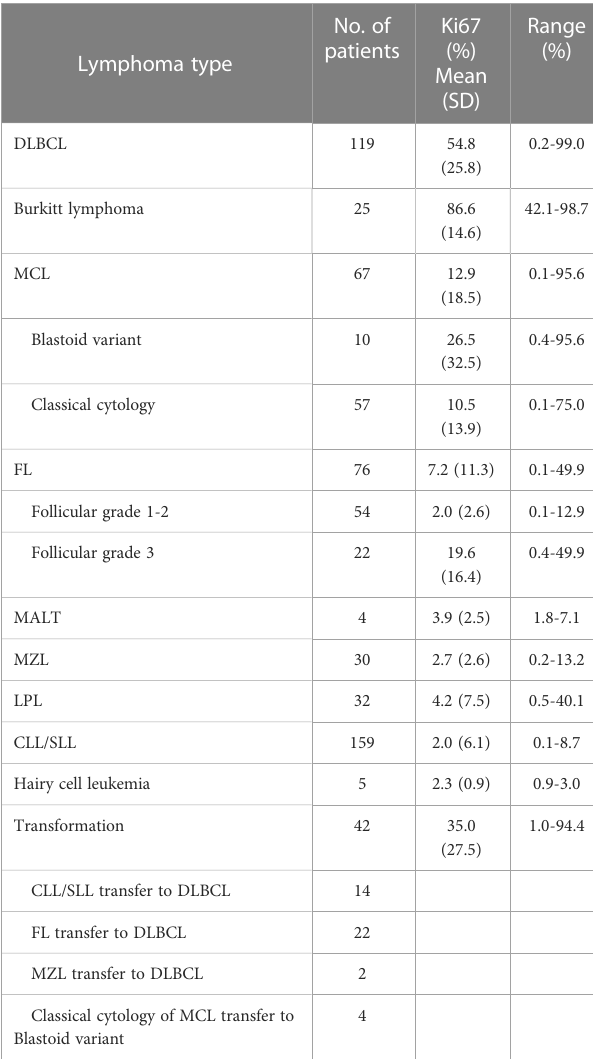
TABLE 1 The positive rate of Ki67 in patients with Non-Hodgkin Lymphoma (WHO Classi fi cation).